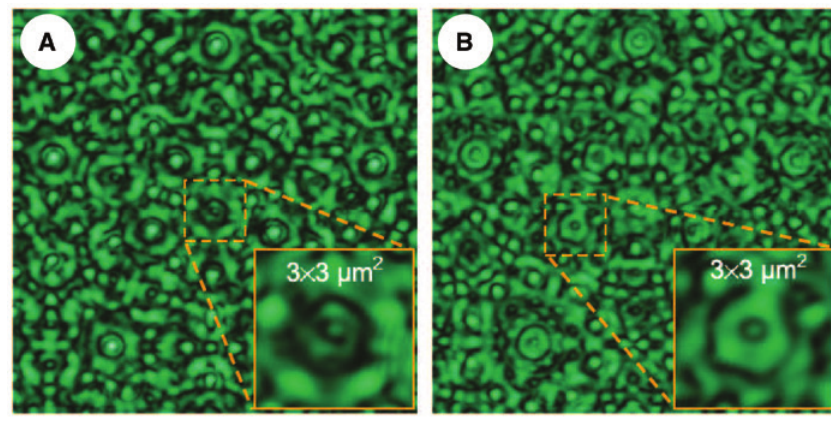
Figure 7: The photonic carpets at wavelength λ = 500 nm seen with a conventional microscope, over an area 20 × 20 μ m 2 . The distances are (A) z = 7 μ m and (B) z = 8.5 μ m. Insets show the superoscillatory hotspots. After